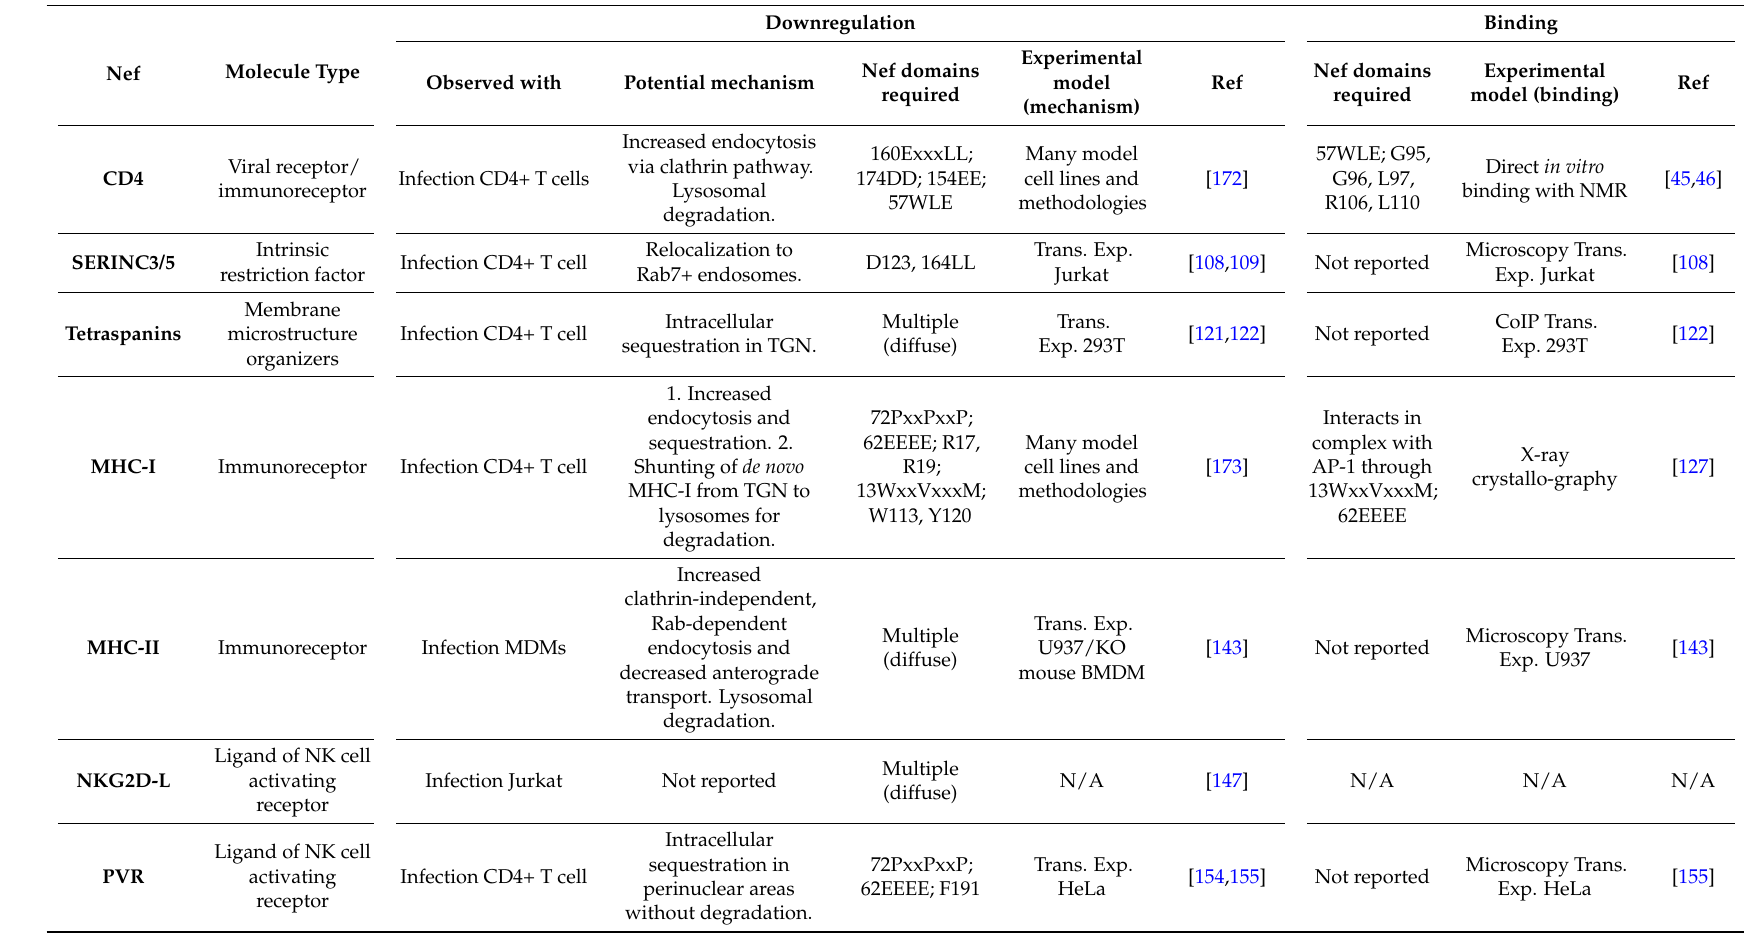
Table 1. Host PM proteins targeted by HIV-1